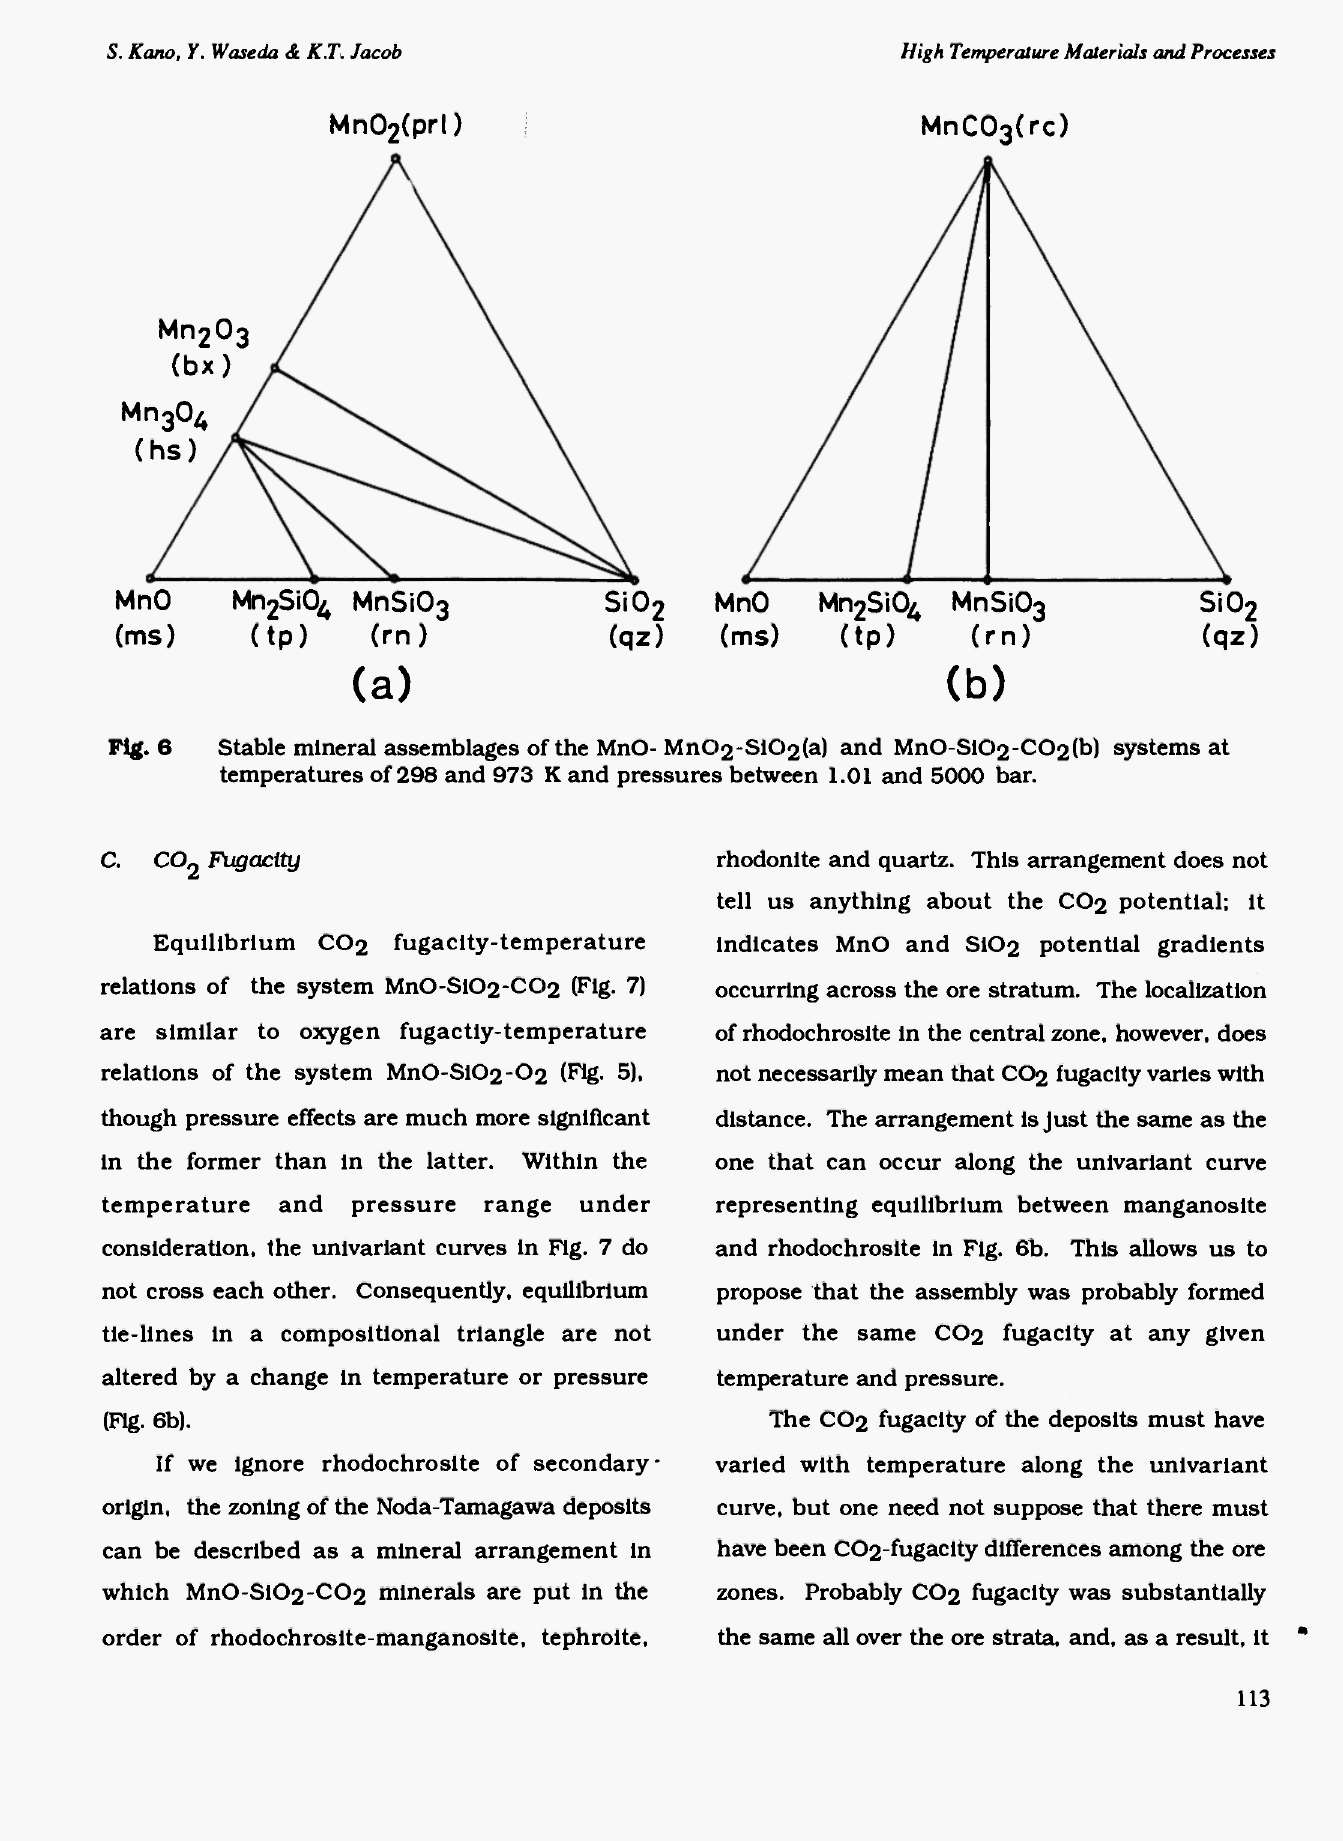
Fig. β Stable mineral assemblages of the MnO- MnC >2 -SiC >2 (a) and Mn0 -SiC >2-C02 (b) systems at temperatures of 298 and 973 Κ and pressures between 1.01 and 5000 bar. rhodonite and quartz. This arrangement does not tell us anything about the CO2 potential; it indicates MnO and S102 potential gradients occurring across the ore stratum. The localization of rhodochrosite in the central zone, however, does not necessarily mean that CO2 fugacity varies with distance. The arrangement is Just the same as the one that can occur along the univariant curve representing equilibrium between